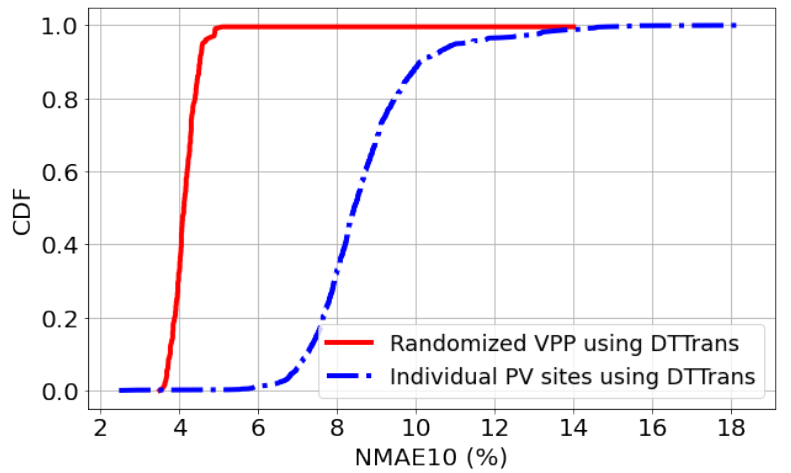
Figure 13. CDF comparison in terms of randomized VPP in